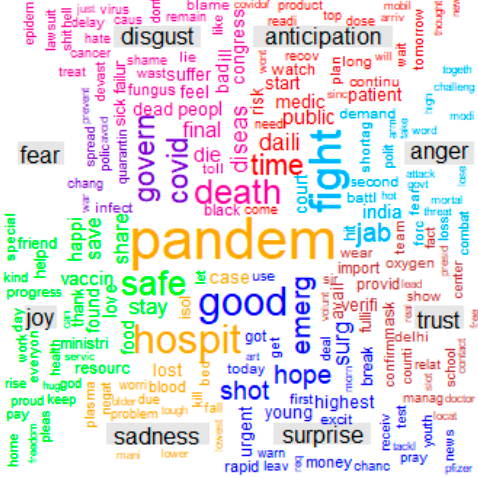
Figure 3. Wordcloud of emotions during infectious disease in May 2021.